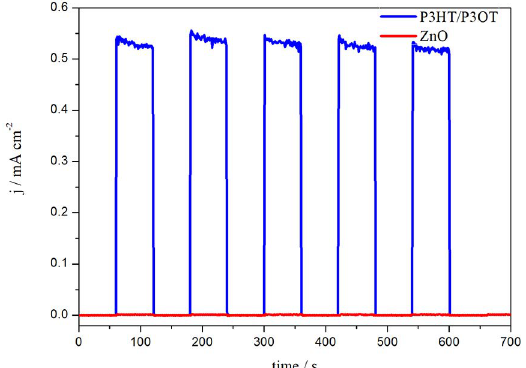
Figure 4. Photochronoamperometry measurements for samples under 100 mW cm -2 of illumination. The lamp was interrupted at a time interval of 60 s.